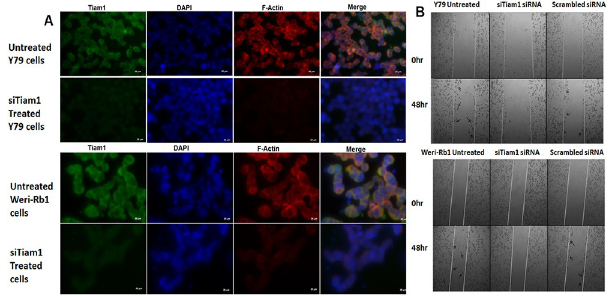
Fig 5. F-actin staining and invasion of Tiam1 deficient RB cell lines. A . Tiam1 silenced Y79 cells and Weri-Rb1 cells were fixed, immunofluorescently labeled for Tiam1, nucleus stained with DAPI, stained with phalloidin and images were taken at 40X in ten fields. Bar represents 20 μ m. B . Phase contrast microscope images of wound healing assay showing the cell migration pattern in Tiam1 deficient retinoblastoma cell lines at 0 hr and 48 hrs post silencing. Tiam1 knockdown cells were unable to migrate whereas the untransfected and control cells showed increased migration, migrated cells were indicated with arrows. The images were acquired using AxioObserver microscope at 5 × objective with 1 ×